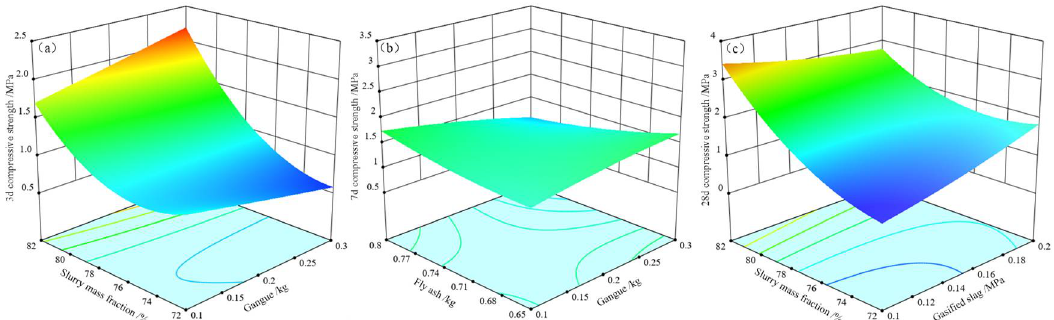
Figure 8. Effect of interaction of response surface factors on the strength of the filler: ( a ) The effect of interaction between slurry mass fraction and gangue dosing on the 3-day strength of the filler; ( b ) the effect of interaction between fly ash and gangue dosing on the 7-day strength of the filler; ( c ) the effect of interaction between slurry mass fraction and gasification slag dosing on the 28-day strength of the